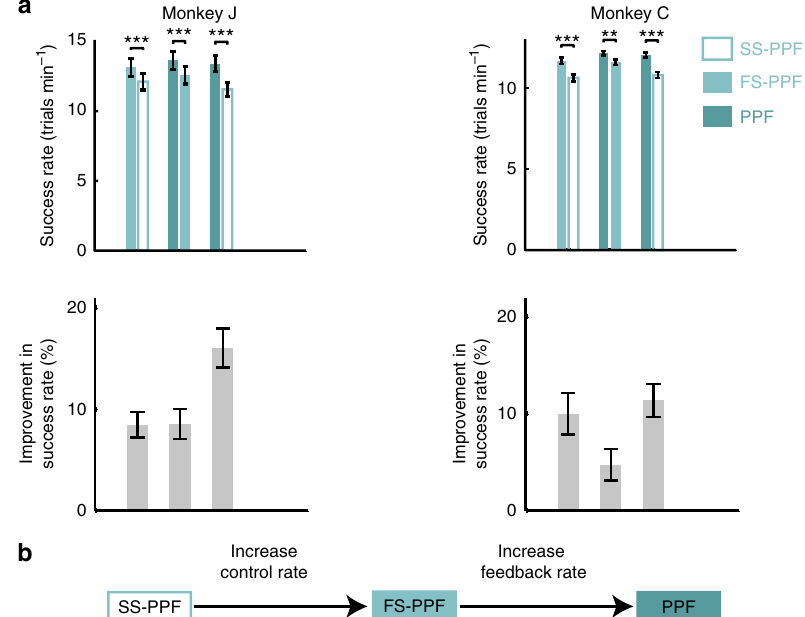
Figure 2 | Rapid control and feedback rates enhance neuroprosthetic control. ( a ) Success rates for monkeys J and C using SS-PPF (white), FS-PPF (light blue) and PPF (dark blue). Each pair of bars indicates a paired comparison between two of the decoders and is obtained by averaging the performance of blocks that were run on the same days. Error bars indicate the s.e.m. Stars between the paired bars indicate a significant change, with one star indicating P o 0.05, two stars indicating P o 0.01 and three stars indicating P o 0.001. The bottom panel shows the percentage improvement in the success rate for the paired bar comparisons in the top panel. Each grey improvement bar is calculated from the paired bars above it (that is, improvement of the left bar compared with the right bar in the paired bar above it). ( b ) SS-PPF has a slow control and a slow feedback rate, FS-PPF has a fast control rate but a slow feedback rate, and PPF has both fast control and fast feedback